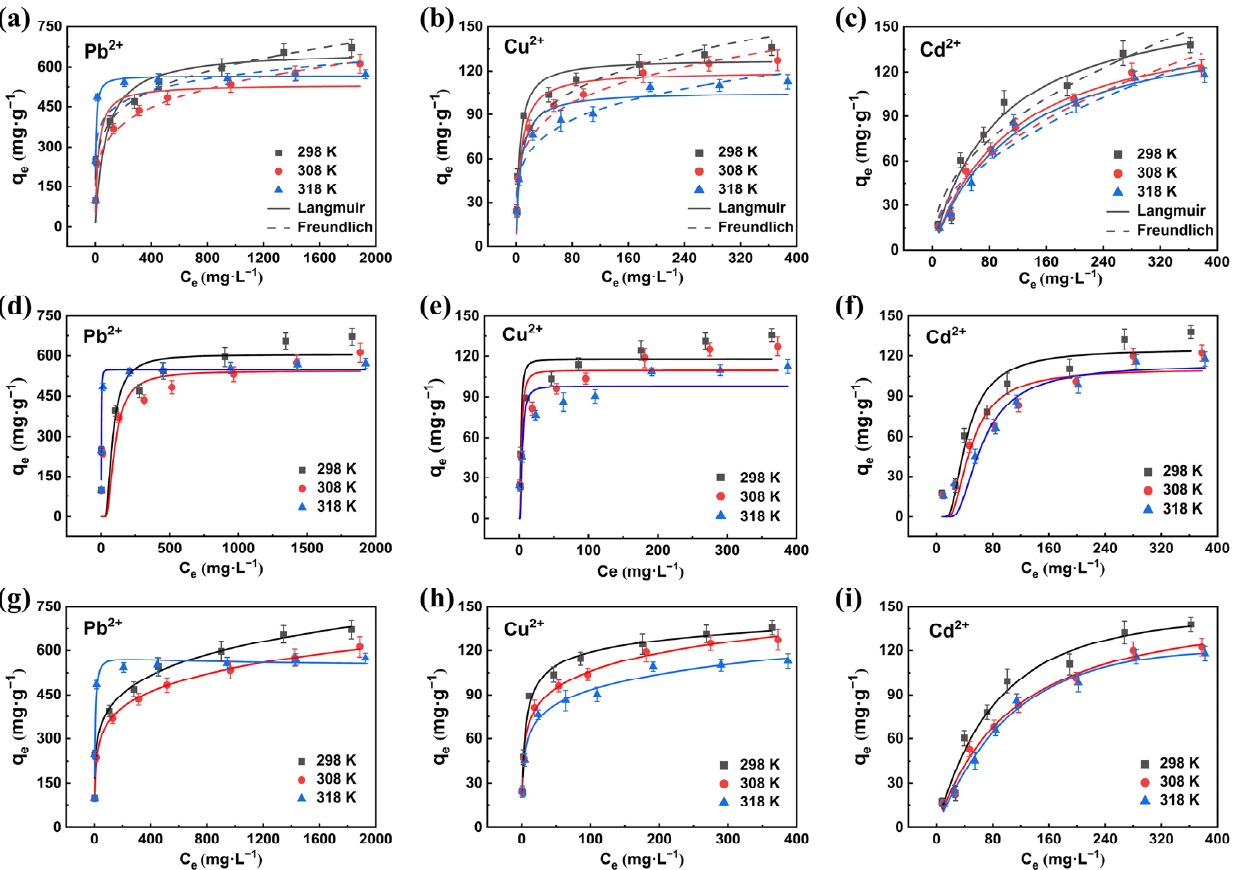
Figure 10. Fitting curves of adsorption isotherms. ( a – c ) Langmuir model and Freundlich model. ( d – f ) Dubinin-Radushkevich model. ( g – i ) Redlich-Peterson model.